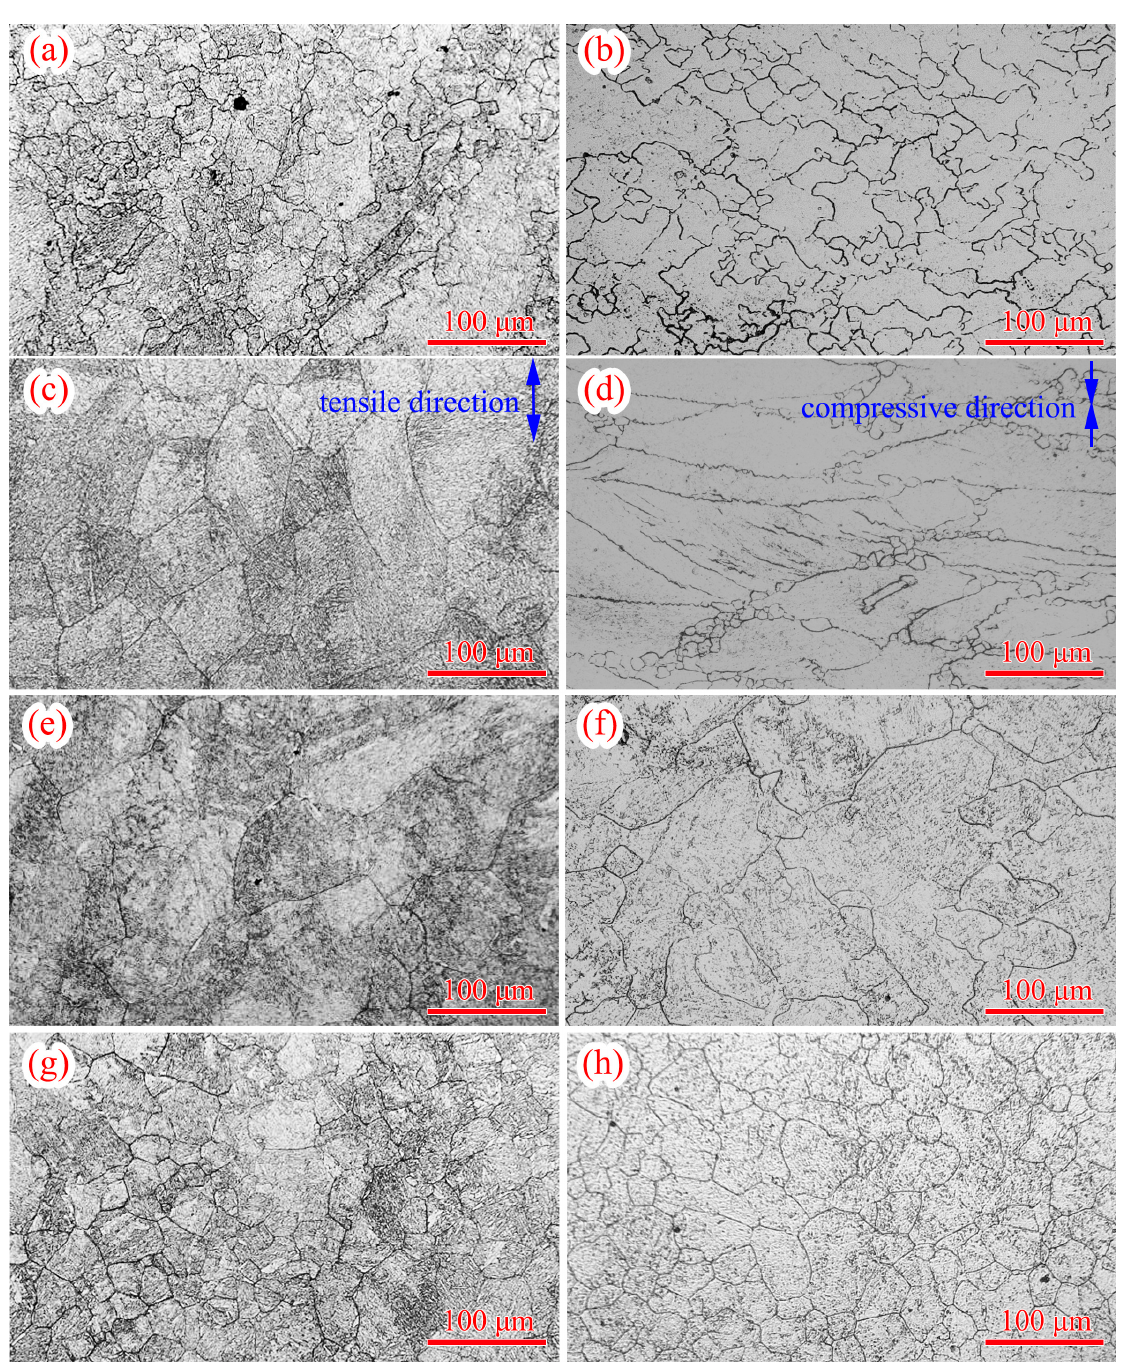
Figure 6. Microstructures of 300M steel after tension at ( a ) 950 °C 0.01 s − 1 , ( c ) 950 °C 10 s − 1 , ( e ) 1150 °C 0.01 s − 1 , ( g ) 1150 °C 10 s − 1 , and after compression at ( b ) 950 °C 0.01 s − 1 , ( d ) 950 °C 10 s − 1 , ( f ) 1150 °C 0.01 s − 1 , ( h ) 1150 °C 10 s − 1 .